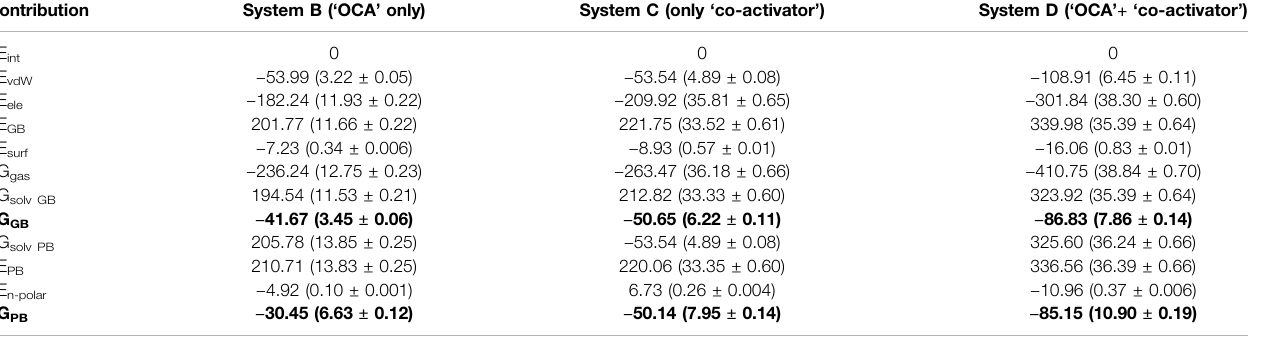
TABLE 4 | The contribution of the binding free energy for ‘ co-activator ’ in Systems B, C and D. In the bracket, the standard deviation and the standard error of mean values are speci fi ed. The standard error of mean values (i.e., the standard deviation divided by the square root of the number of snapshots) to depict the precision of the MM- GBSA and MM-PBSA methods to estimate the binding free energies. The bold values indicates the total binding free energy.